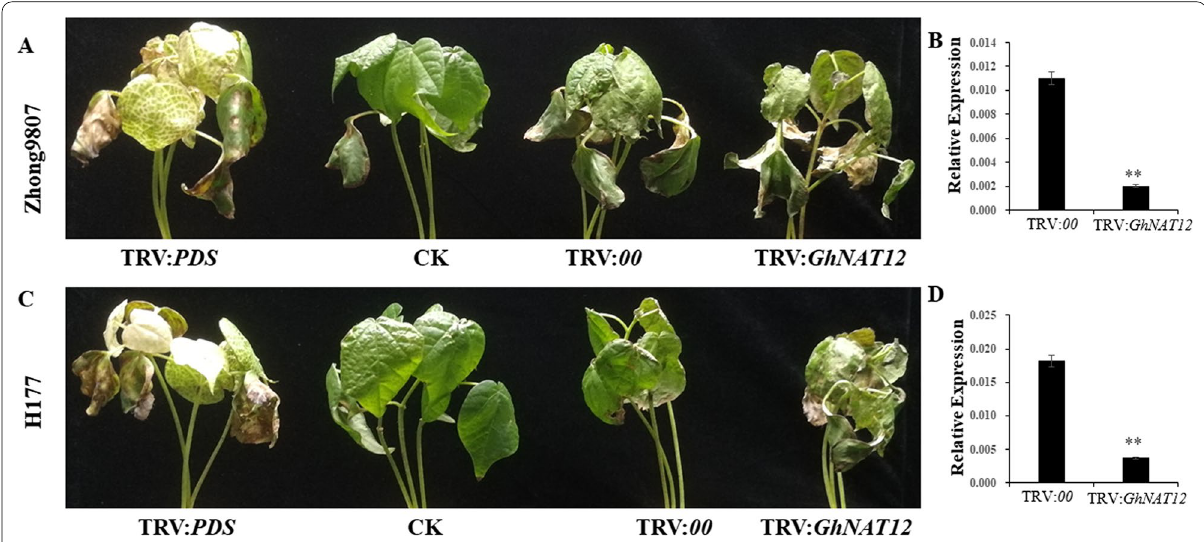
Fig. 8 The phenotype of cotton leaves of GhNAT 12 silenced Zhong9807 and H177 under NaCl and PEG6000 treatment, respectively. A Phenotype of cotton leaves of GhNAT 12 silenced Zhong9807, the CK was treated with 0 mmol 200 mmol L − 1 NaCl. B GhNAT12 gene silence efficiency detection in Zhong9807. C Phenotype of cotton leaves of GhNAT 12 silenced in H177, CK was · treated with 0% PEG6000, and TRV: 00 and TRV: GhNAT12 treated with 12% PEG6000. D GhNAT12 gene silence efficiency detection in